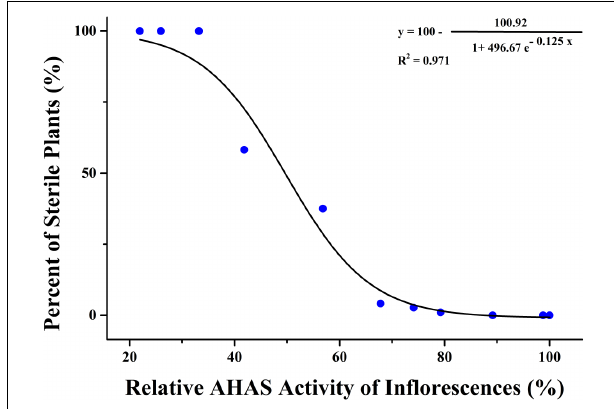
# Data in the table are expressed by mean ± SD, n = 6. Data followed by different superscript capital letter within same column means significant difference at P = 0.01 level. ∗ Relative activity of AHAS was determined as the percentage of absorbance value of each sample of TBM-treated plants and the corresponding sample of the control plants (treated with 0 mg · L − 1 of